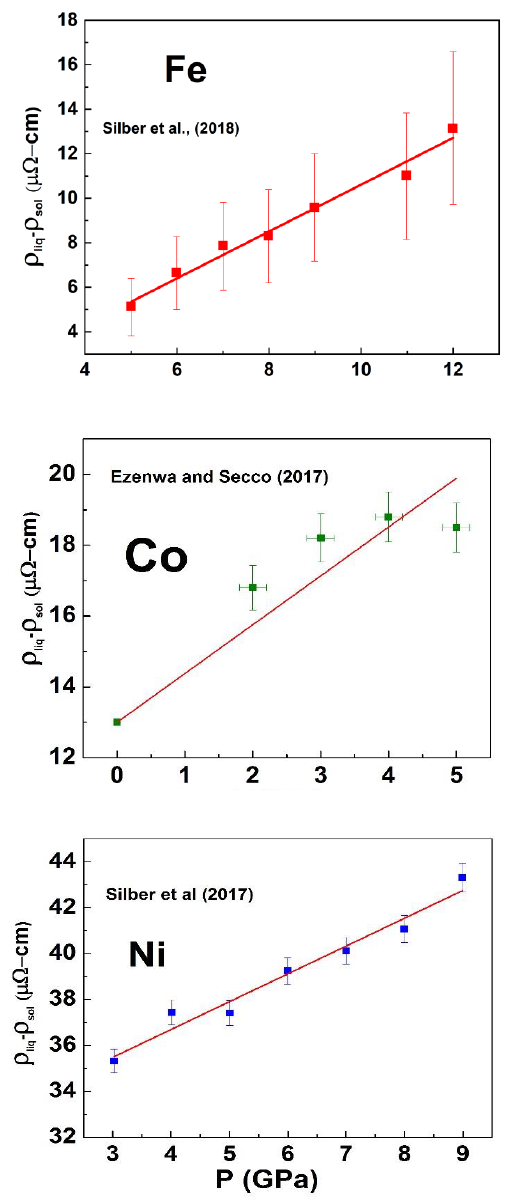
Figure 4. The di ff erence in electrical resistivity value of solid and liquid Fe, Co, and Ni at the melting transition with increasing P . The least squares fits of ρ liq − ρ sol vs. P for Fe, Co, and Ni are, respectively, (11.33 ± 3.19) + 0.74 P , (12.99 ± 0.0016) + (1.35 ± 0.6) P , and (31.84 ± 0.61) + (1.21 ± 0.1) P .